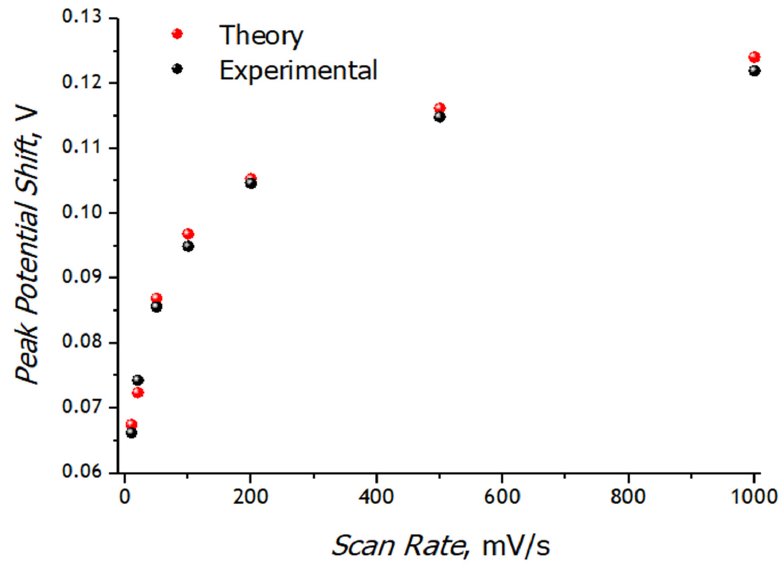
Figure 15. Comparison of experimental data on the shift of the ferrocenemethanol peak potential with a sweep rate change. with a sweep rate